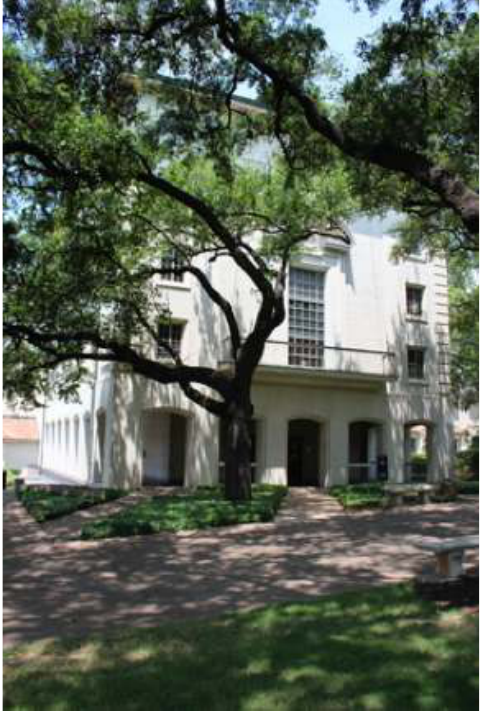
Figure 2: Calhoun